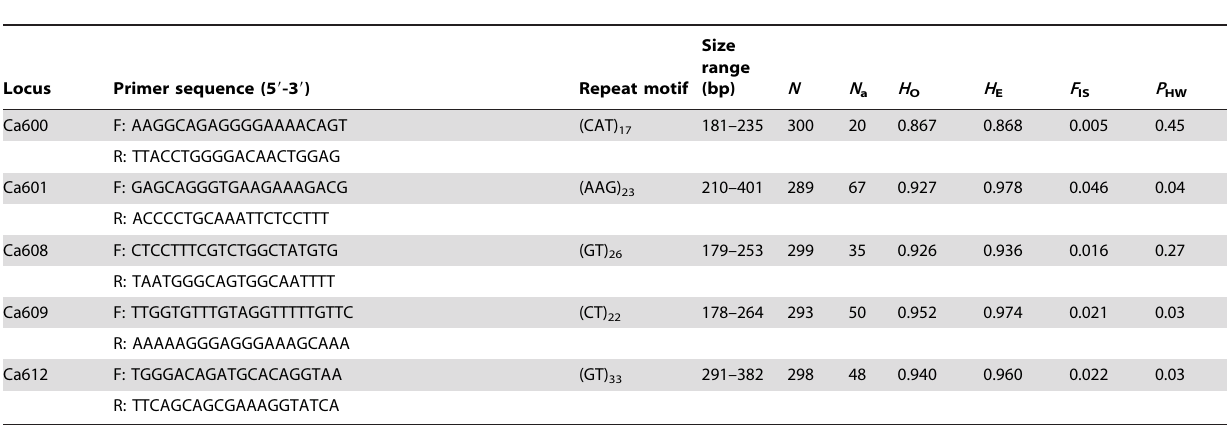
Table 3. Global characteristics of five polymorphic microsatellite loci for Coralliophila abbreviata .